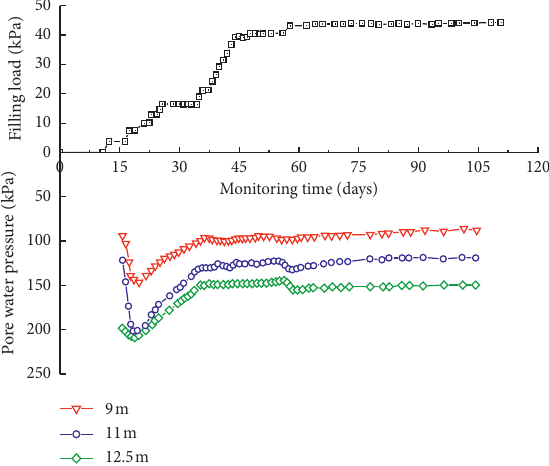
Figure 18: Variation of pore water pressure with filling